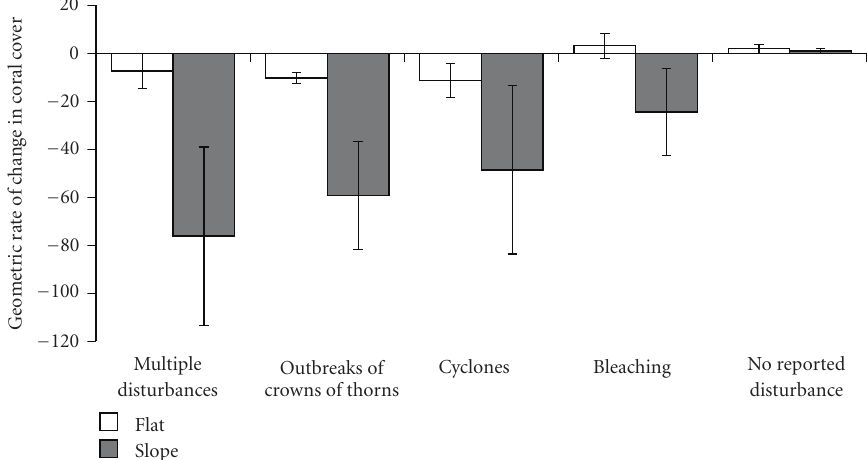
Figure 4: Variation in the mean ( ± SE) annual geometric rate of change in total cover of scleractinian corals, for years (between 1979 and 2008) during which outbreaks of A. planci (1979–1986, 2006–2008), cyclones (1983 and 1991), or bleaching (1983, 1987, 1991, 1994, 2002, 2003, and 2007) were